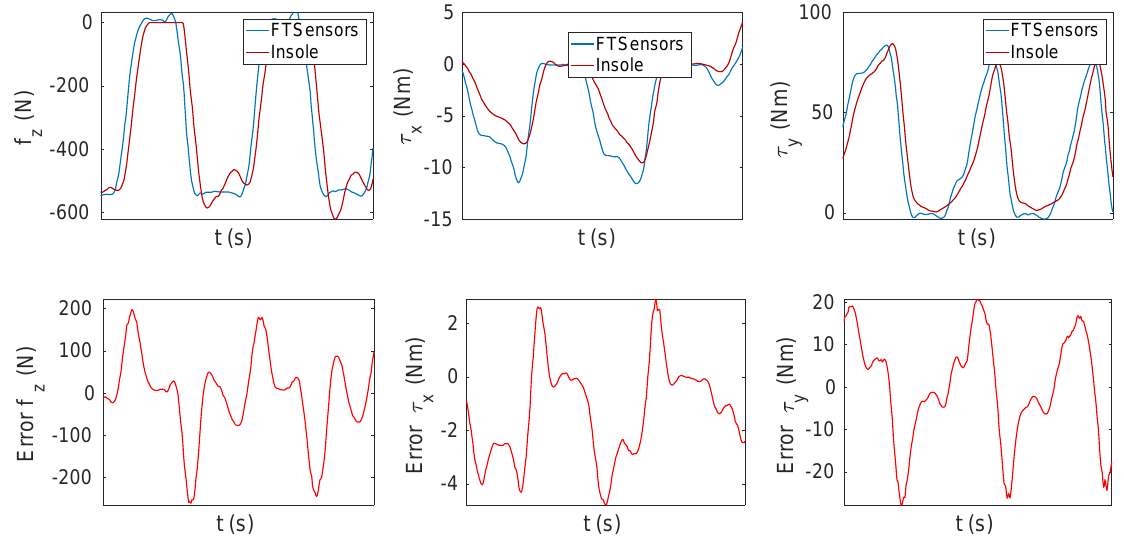
Figure 10. Zoomed view of the tracking error to highlight the delay between FT sensors and insole estimations.